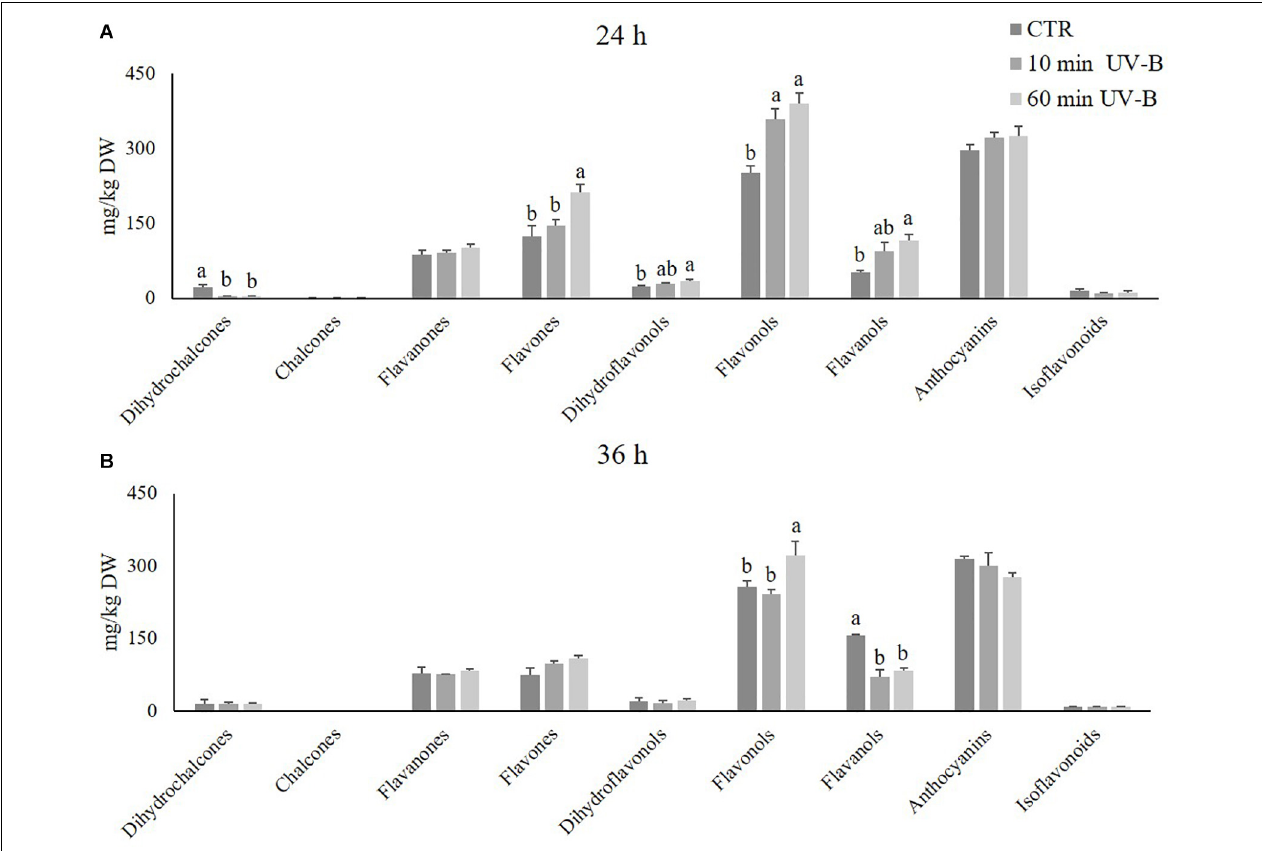
FIGURE 2 | Concentration (mg/kg DW) of several flavonoid classes (dihydrochalcones, chalcones, flavanones, flavones, dihydroflavonols, flavonols, flavanols, anthocyanins, and isoflavonoids) in the pulp of peaches exposed to UV-B radiation for either 10 or 60 min, and sampled after 24 h (A) and 36 h (B) from the exposure. Data are mean ± SE of five biological replicates. Different letters correspond to statistically significant differences according to one-way ANOVA followed by Tukey–Kramer post hoc test ( P ≤ 0.05).